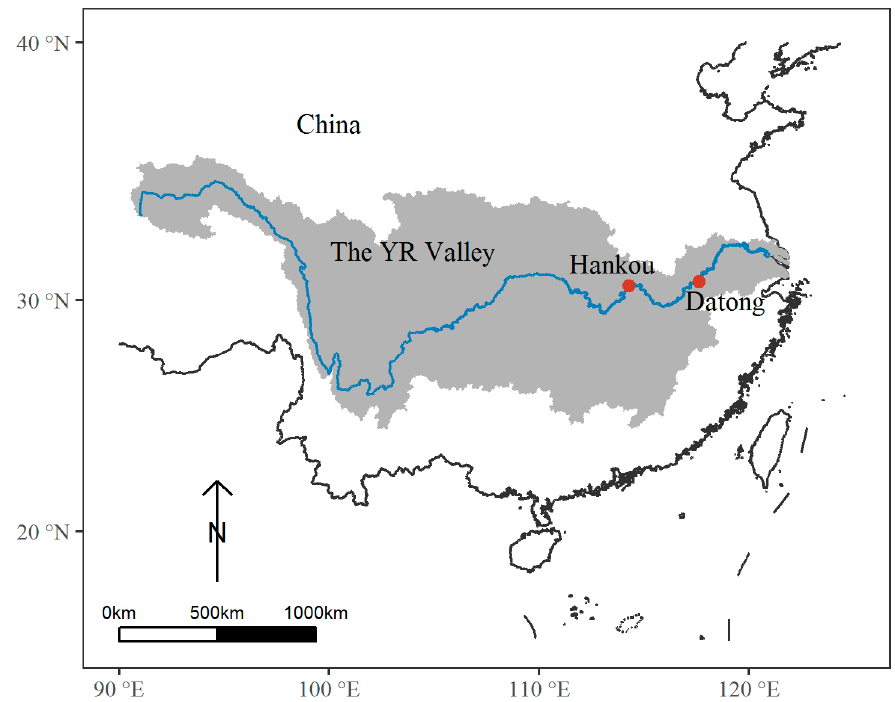
Figure 1. Locations of the Yangtze River Valley (YR Valley) in China and two hydrological stations explored in this study.